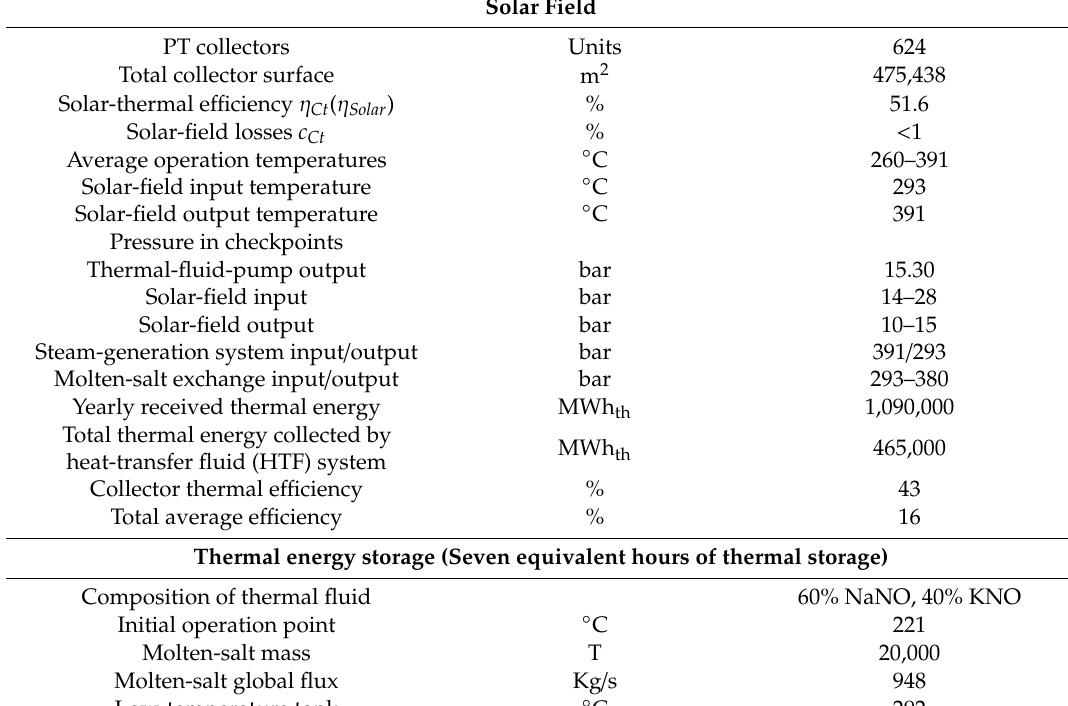
Table 2. Reference design values for 50MW e PT plant with two-tank molten-salt thermal energy storage (TES)